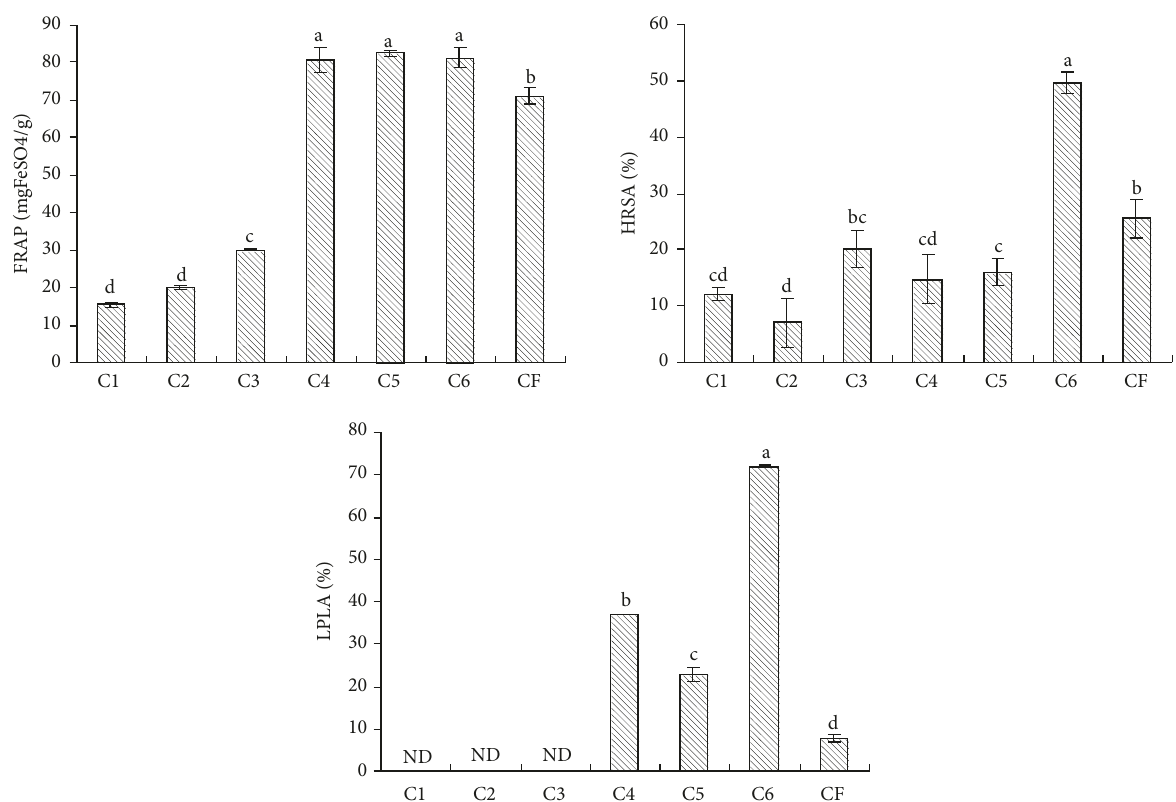
Figure 3: Antioxidant activities of constituents separated from the chloroform fraction. The values are means ± standard deviations of triplicate analyses. Columns labeled with different letters are significantly different (𝑃 < 0.01) by Duncan test. ND means not detected.